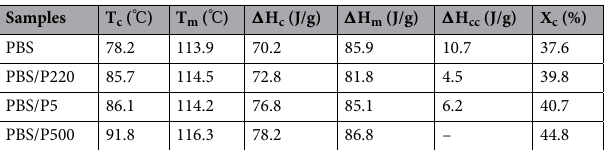
Table 2. Statistical data of DSC for PBS and PBS/PTFE composites.